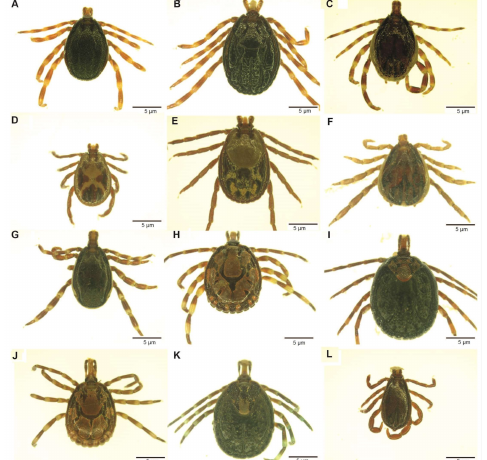
Figure 2. Images of adults of tick species collected from camels in northern Kenya. ( A ) Hyalomma rufipes male; ( B ) Hy. rufipes , female; ( C ) Hyalomma impeltatum , male; ( D ) Rhipicephalus pulchellus , male; ( E ) Rh. pulchellus , female; ( F ) Hyalomma dromedarii , male; ( G ) Hyalomma truncatum , male; ( H ) Amblyomma lepidum , male; ( I ) Am. lepidum , female; ( J ) Amblyomma gemma , male; ( K ) Am. gemma , female; ( L ) Rhipicephalus camicasi , male. The images were staged under a Stemi 2000-C microscope (Zeiss, Oberkochen, Germany) after thawing from liquid nitrogen and photographed using a digital microscope connected to an Axio-cam ERc 5s camera